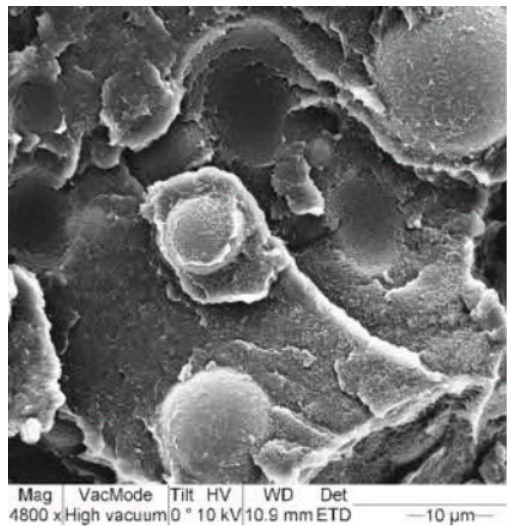
Figure 8. SEM observation for PA6 and hollow glass bubble composites [28].